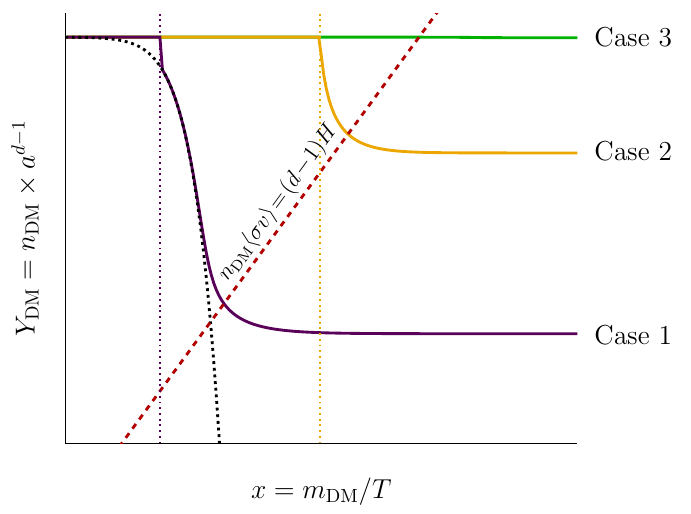
FIG. 1. SM-neutrinos, total probability of (cid:28) -exit at the Earth surface per angle under the horizon, for an incoming Figure 6 . Evolution of the dark-matter yield Y DM = n DM a d (cid:0) 1 ( / n DM =s before freeze-out) as neutrino of energy E (cid:23) = 10 EeV. a function of x = m DM =T in the string theory scenario, in 4 dimensions. The black-dotted line represents the value that the yield would follow if the dark-matter particles always had a constant mass equal to m DM , and if thermal equilibrium could be maintained all along the history of the universe. In Cases 1 (violet line) and 2 (yellow line), two di(cid:11)erent values of the phase transition temperature T c are considered. In Case 3 (green line), the decoupling from the thermal bath takes place while dark matter is still relativistic, and no phase transition can take place